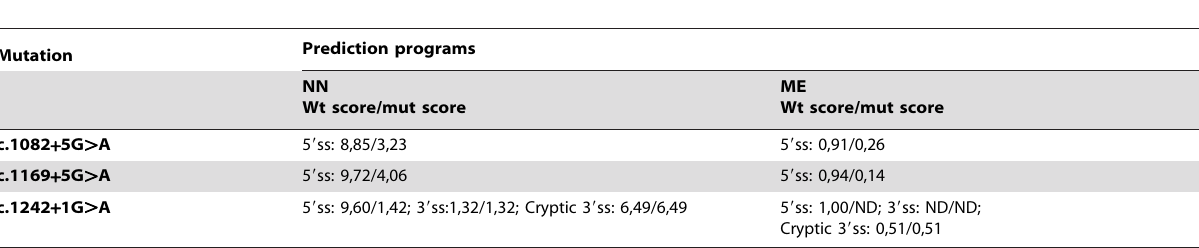
Table 2. In silico analysis of novel splicing mutations.